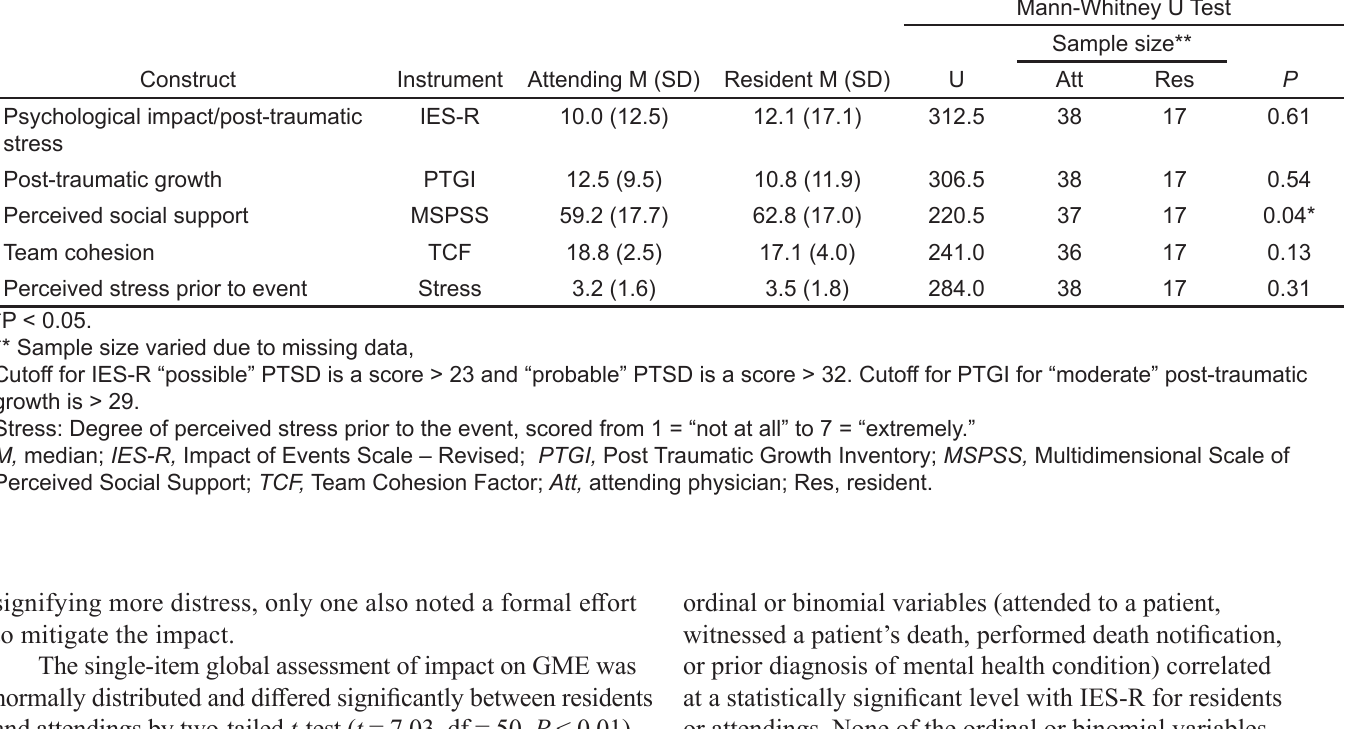
Table 4. Outcomes of measured variables by graduate medical education role.